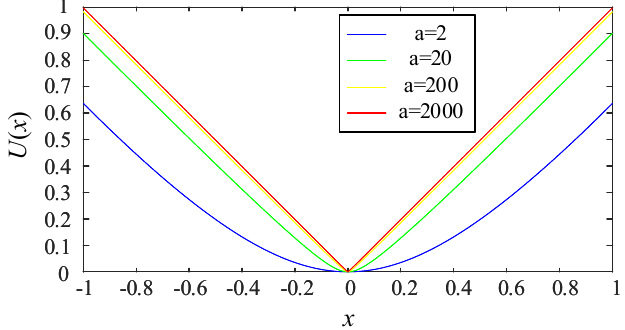
Figure 6. Virtual potential energy U ( x ) − SoC